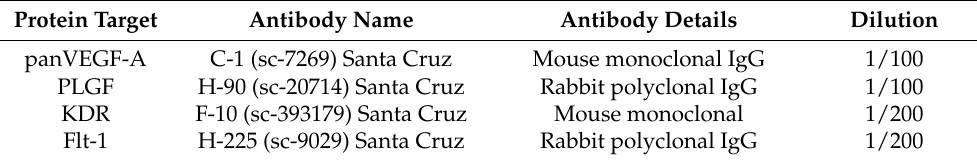
Table 1. Antibodies used for